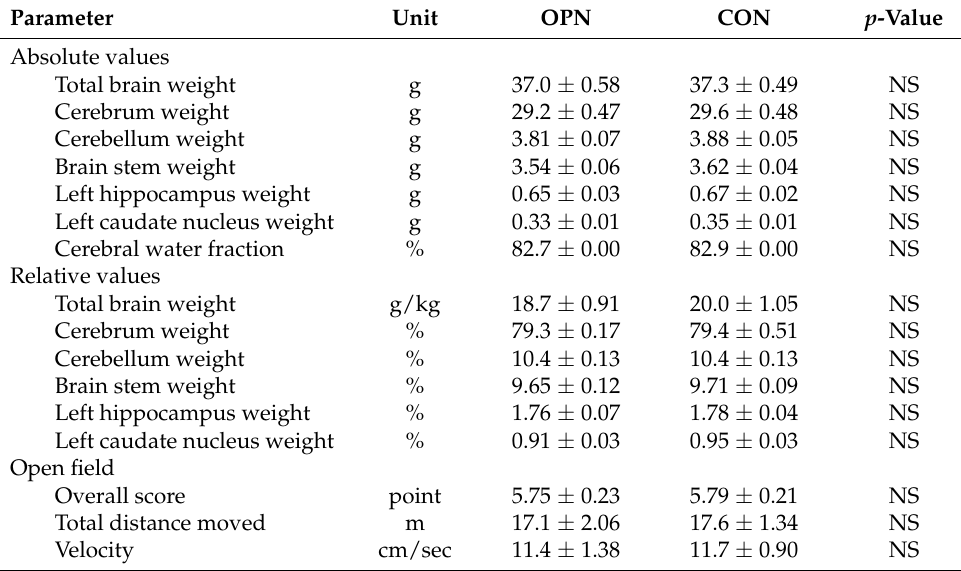
Table 4. Structural and functional brain related outcomes of preterm pigs. The pigs received a bovine milk diet (CON, n = 19) or the milk diet supplemented with OPN (OPN, n = 15–16). Parameter Unit OPN CON p -Value Absolute values Total brain weight g 37.0 ± 0.58 37.3 ± 0.49 NS Cerebrum weight g 29.2 ± 0.47 29.6 ± 0.48 NS Cerebellum weight g 3.81 ± 0.07 3.88 ± 0.05 NS Brain stem weight g 3.54 ± 0.06 3.62 ± 0.04 Left hippocampus weight g Left caudate nucleus weight g 0.33 ± 0.01 Cerebral water fraction % 82.7 ± 0.00 NS Relative values Total brain weight g/kg 18.7 ± 0.91 20.0 ± 1.05 Cerebrum weight % 79.3 ± 0.17 79.4 ± 0.51 Cerebellum weight % 10.4 ± 0.13 Brain stem weight Left hippocampus weight Left caudate nucleus weight % NS Open field Overall score point 5.75 ± 0.23 5.79 ± 0.21 NS Total distance moved m 17.1 ± 2.06 17.6 ± 1.34 NS Velocity cm/sec 11.4 ± 1.38 11.7 ± 0.90